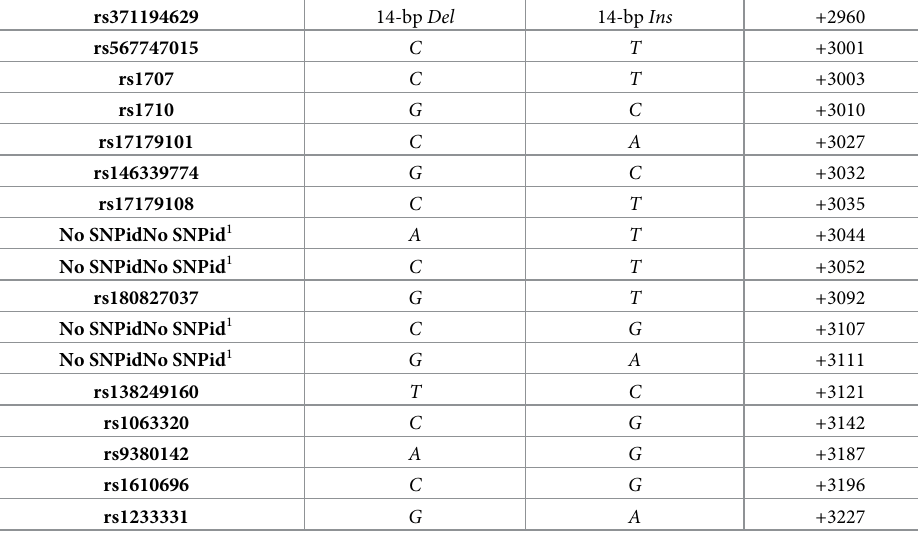
Table 2. The 17 sites of the HLA-G 3’-UTR region analyzed in this